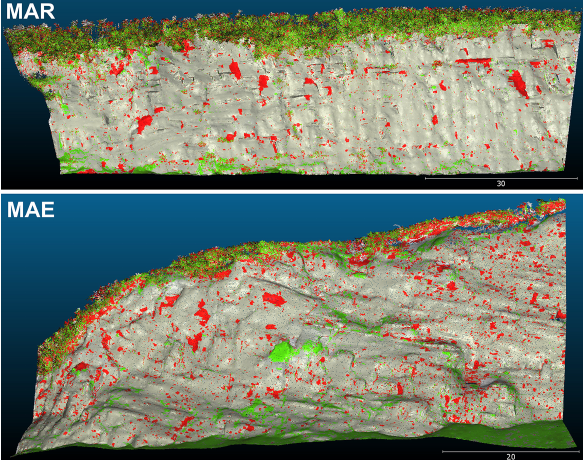
Figure A1. Point cloud of main changes between the first (14 June 2019) and last (18 December 2020) scan surveys of MAR and MAE sites. Red points show negative changes; green points show positive changes.